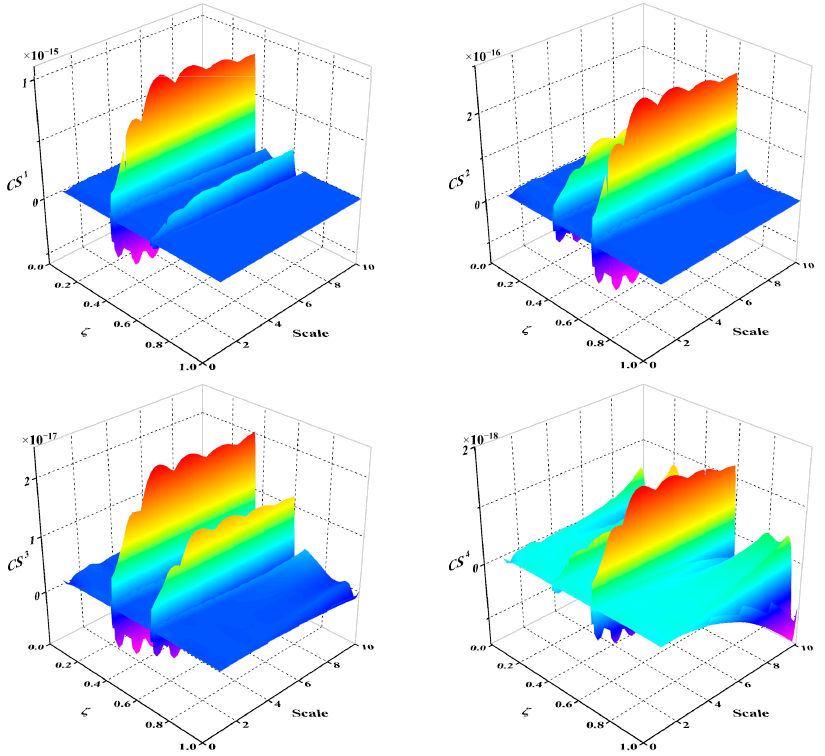
Figure 12. CS ( b, s ) of the extended SSSM boundary under scenario Figure 12. CS ( b , s ) of the extended SSSM boundary under scenario I.